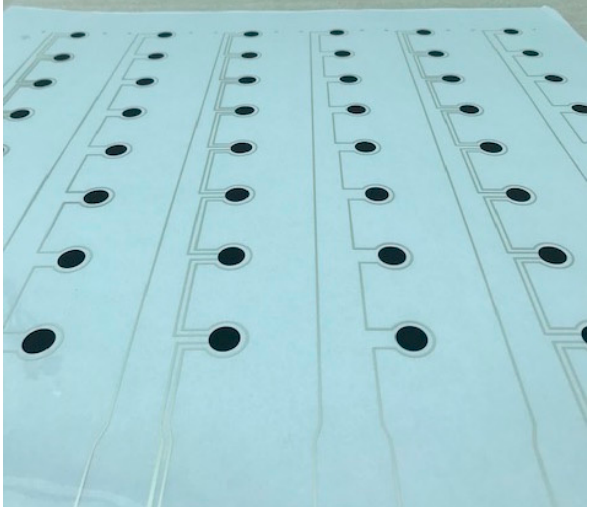
Figure 5. PET sheet screen-printed with multiples of the QTSS™ prototype pressure sensor strip design.